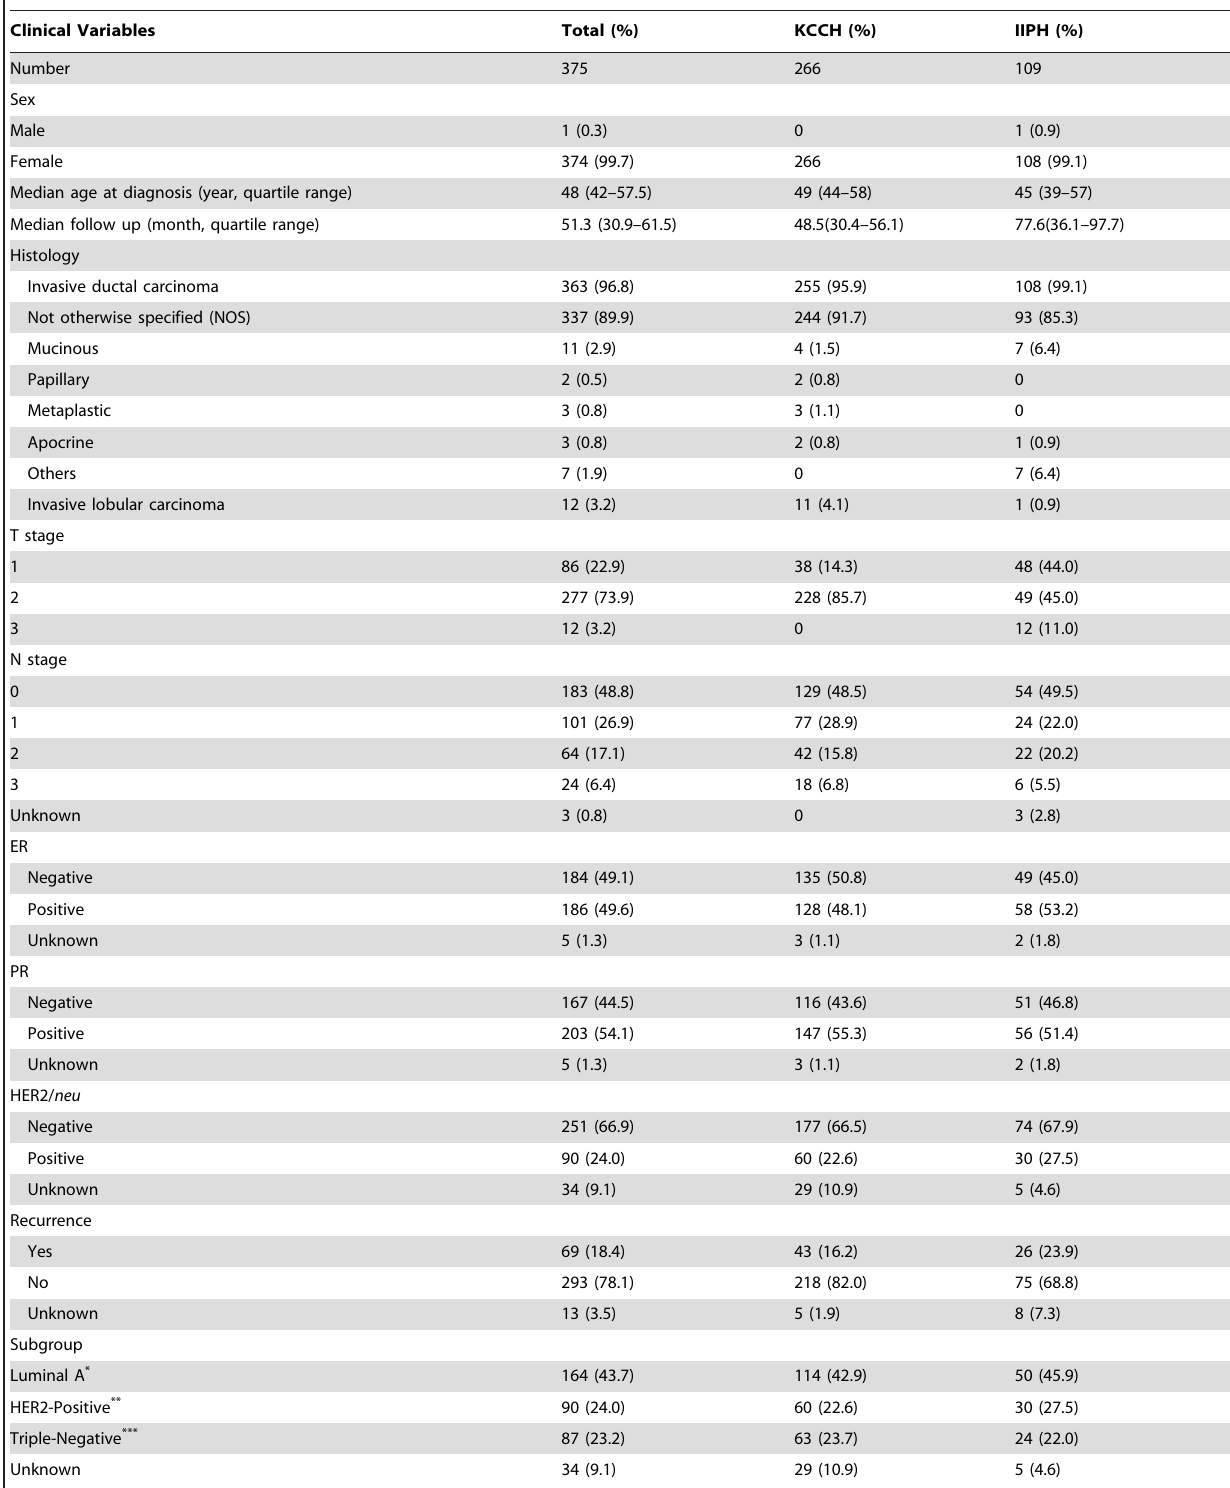
Table 1. Clinicopathological characteristics of breast cancer